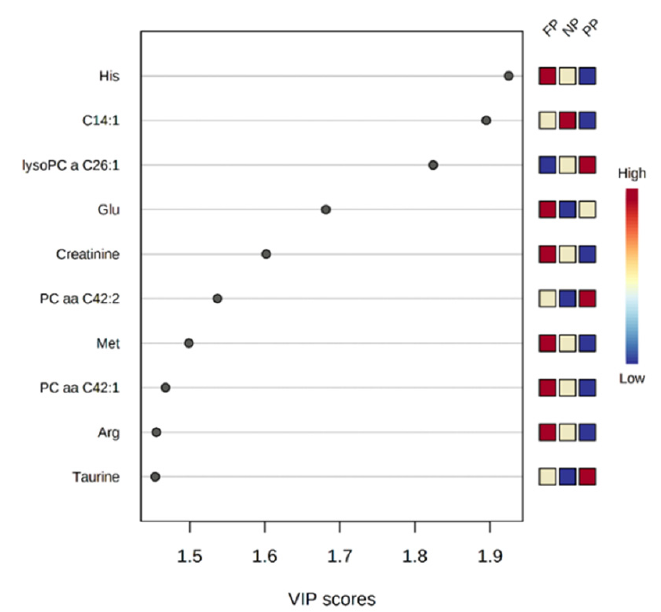
Figure 3. Top 10 metabolites (VIP scores) of dams in the pre-delivery stage associated to the different prenatal treatments (NP, PP and FP).